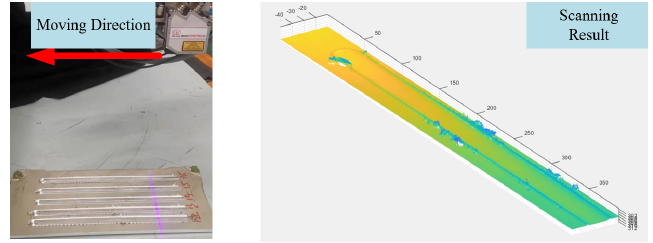
Figure 11. Weld seam scanning